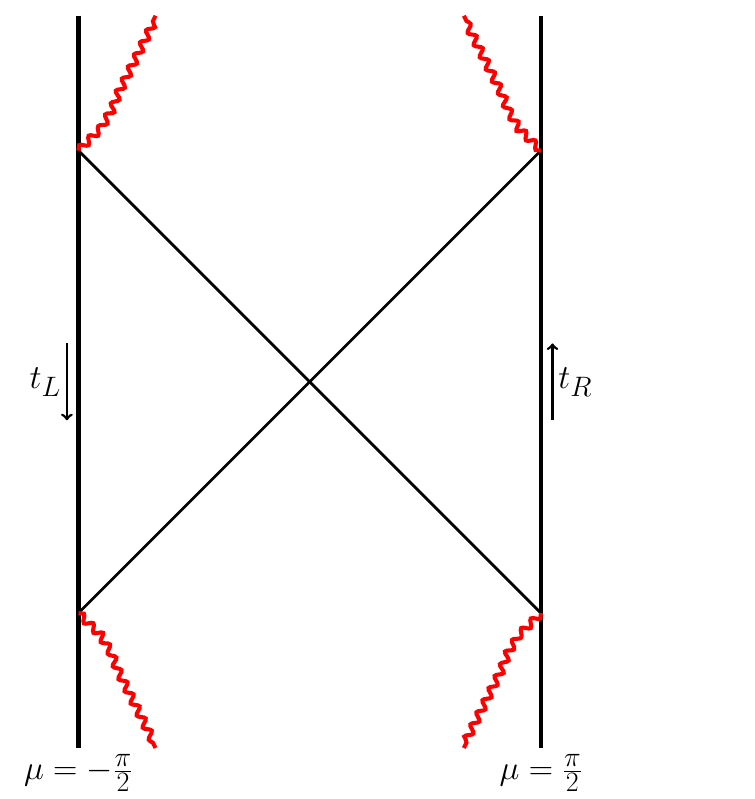
Figure 3 . We draw the Penrose diagram for the AdS 2 black hole in ( (cid:28); (cid:22) ) space where the wiggly red lines represent the location of past and future singularities. We draw here the case where the singularities are timelike with (cid:30) 0 = ( L (cid:22) (cid:30) ) = 1 = 2. space assuming the viewpoint of the dimensional reduction from higher dimensions. When (cid:30) > L (cid:22) (cid:30) ( (cid:30) < L (cid:22) (cid:30) ), the singularities are timelike (spacelike) where (cid:30) 0 0 positive by de(cid:12)nition. If (cid:30) = L (cid:22) (cid:30) , the singularities are lightlike. In this note, we shall 0